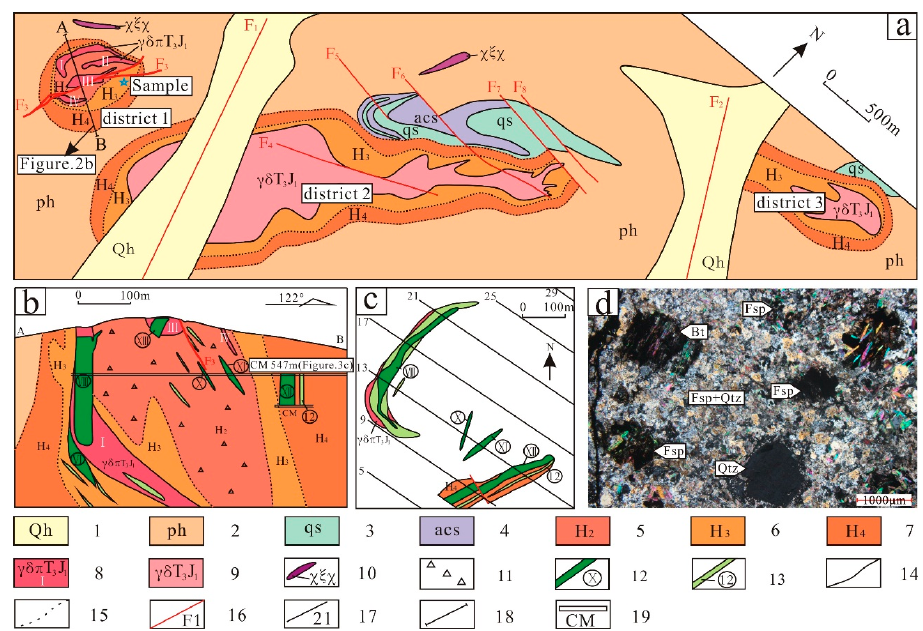
Figure 2. ( a ) Geological map of the Yanghuidongzi deposit [24], ( b ) profile of exploration Line 13 (A–B) [24], ( c ) the tunnel engineering plan at a 547 m elevation in the Yanghuidongzi deposit [24], ( d )